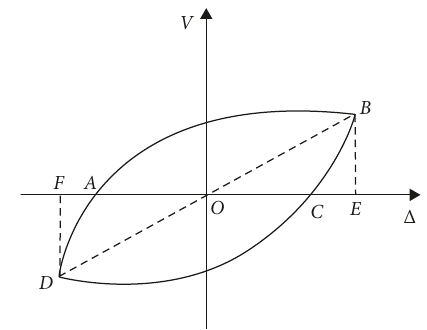
Figure 9: Calculation of equivalent viscous coefficient.